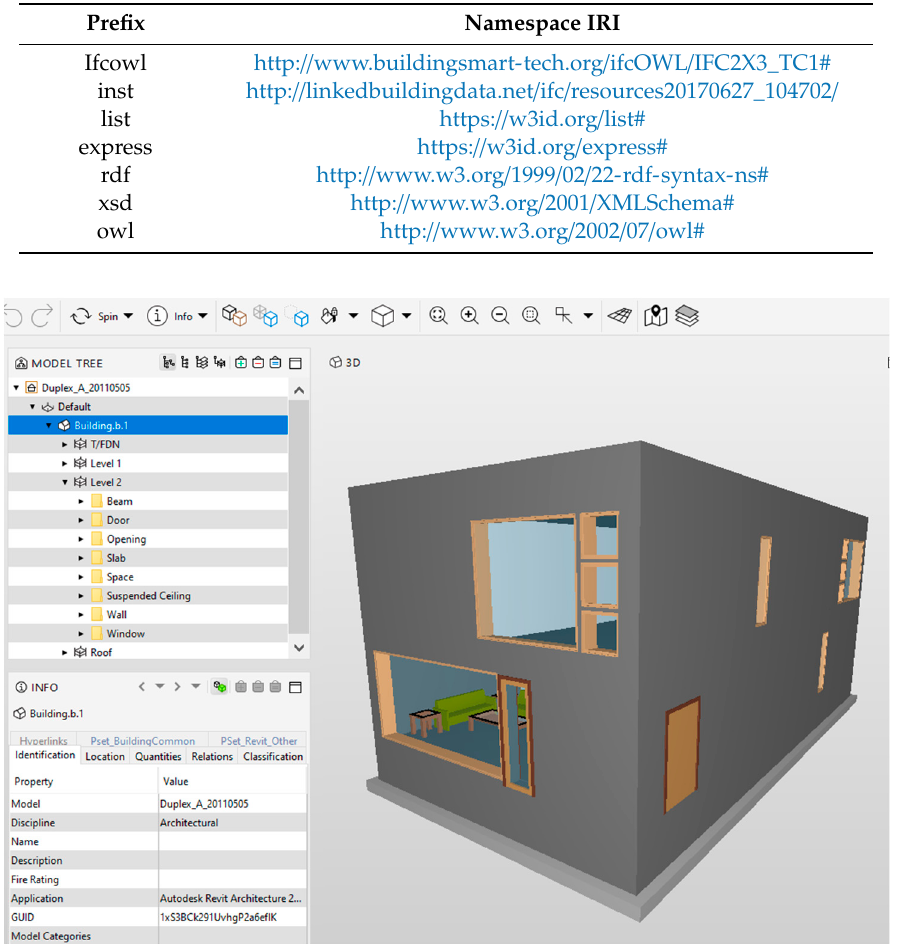
Figure 4. A duplex apartment BIM project.